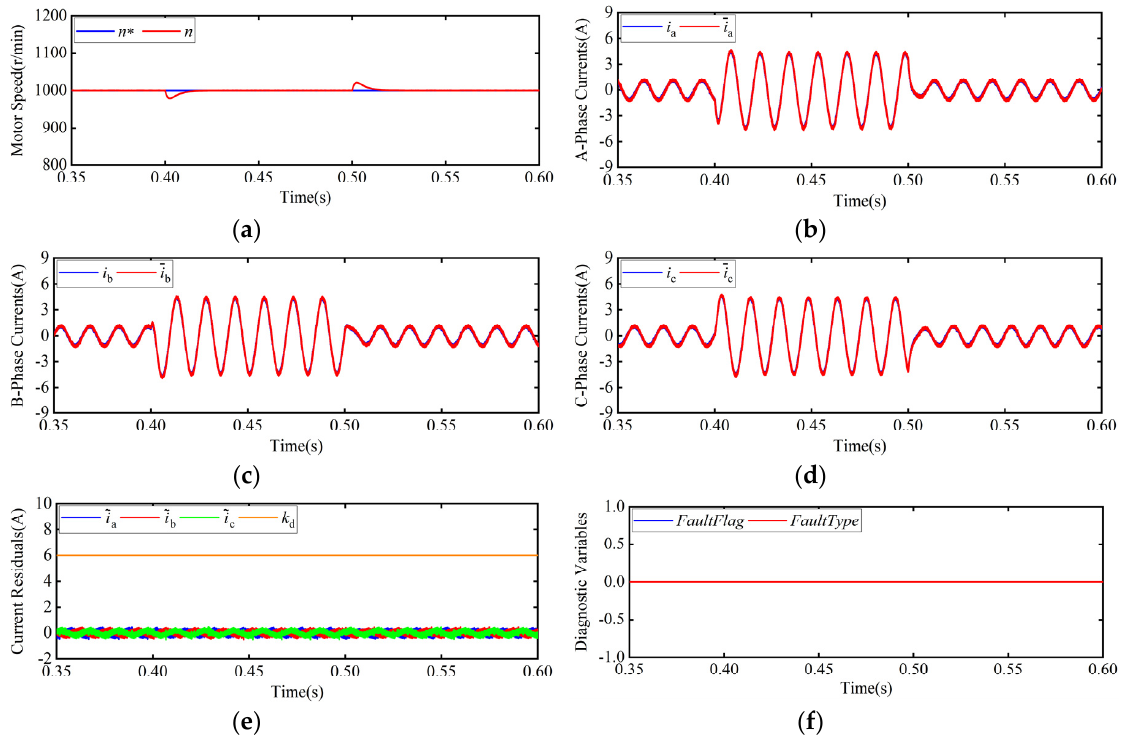
Figure 9. Motor operation in load variations: ( a ) motor speed; ( b ) A-phase currents; ( c ) B-phase currents; ( d ) C-phase currents; ( e ) current residuals; ( f ) diagnostic variables.